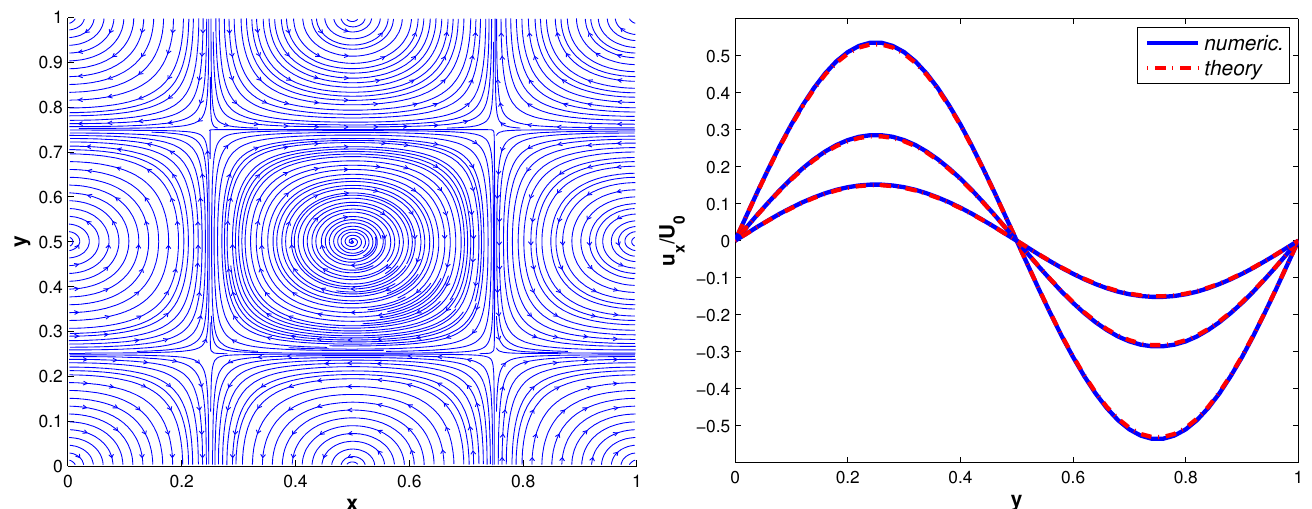
Figure 3. Taylor–Green vortex. The velocity streamlines are presented in the ( first slide ). The velocity profiles u x ( x , y = L /2, t ) for three different moments of time t = 2 × 10 4 , t = 4 × 10 4 , t = 6 × 10 4 obtained analytically and numerically are presented ( second slide ), and the spatial variables x , y are normalized on the domain length L .